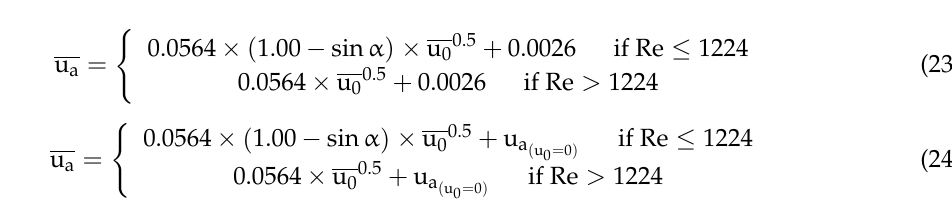
Figure 14. Linear regression average between the velocity at the opening and u (cid:2868) (cid:3364)(cid:3364)(cid:3364) (cid:2868).(cid:2873)(cid:2868) (cid:4666)1.00 (cid:3398) sinα(cid:4667) .